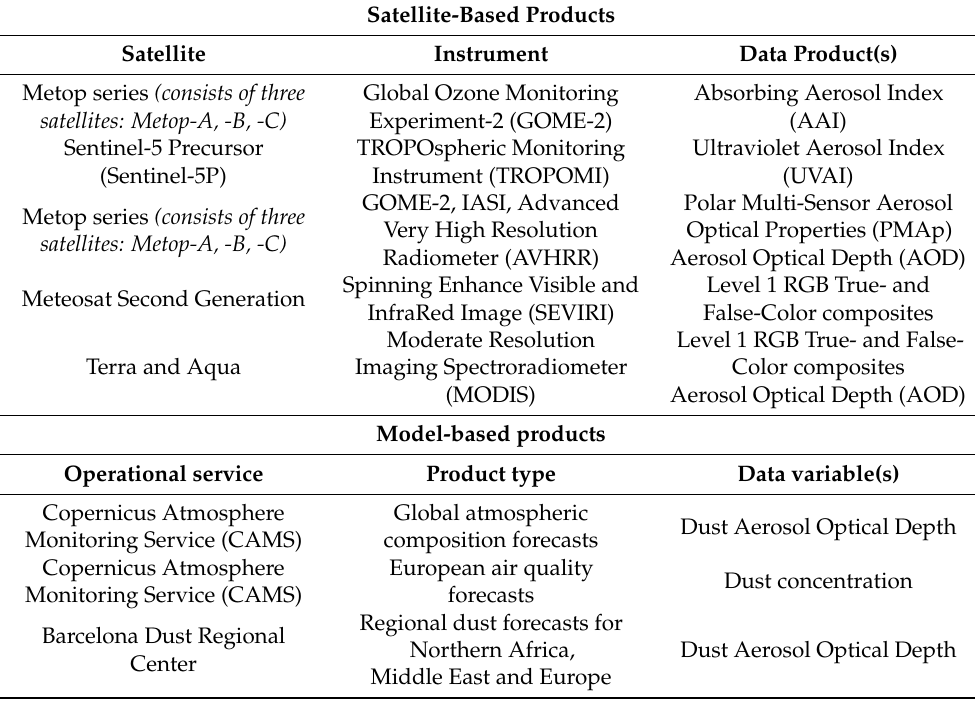
Table A2. Overview of satellite-, model- and ground-based products featured in the thematic module on dust monitoring and